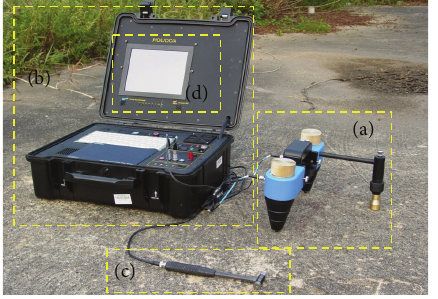
Figure 1: PiScanner system. (a) PiScan Probe, (b) POLCCA, (c) instrumented hammer, and (d) PiScanner Analyzer.